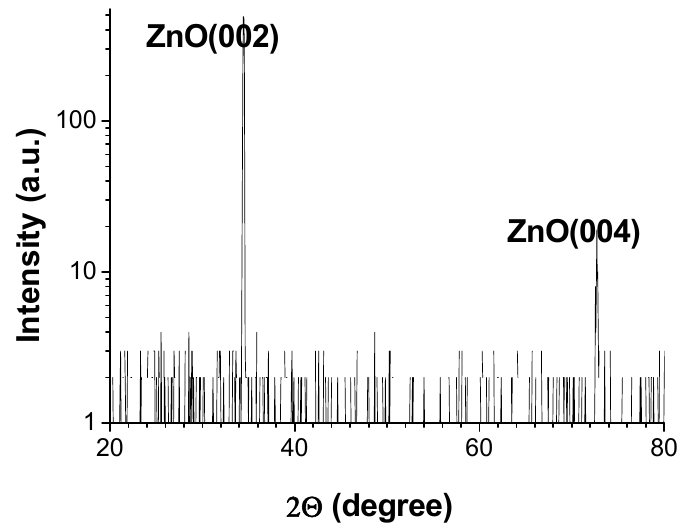
Figure 2. XRD pattern of an aligned ZnO NR array grown on a quartz substrate.